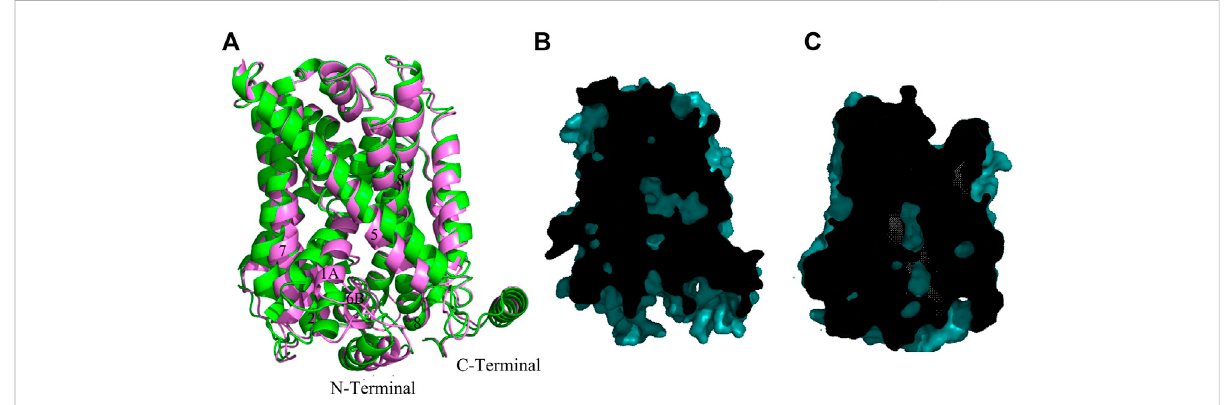
FIGURE 3 Homology model of xCT inward facing occluded conformation. (A) Superimposition of the model 286 (green) and model 283 (pink). (B,C) Sliced-surface representations of the model 283 and GkApcT inward-occluded structure (PBD: 6F34) (Jungnickel, Parker, and Newstead 2018)